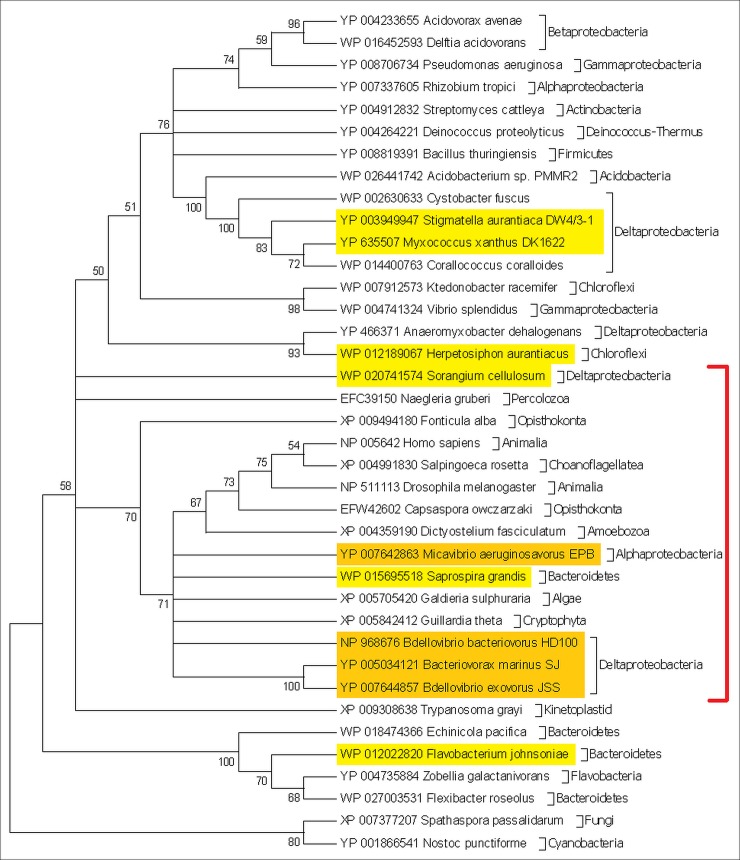
Maximum-likelihood phylogenetic tree of the tryptophan 2,3-dioxygenase protein.The percentage of trees in which the associated taxa clustered together (out of 100 bootstraps) is shown next to the branches; branches with <50% were collapsed. Obligate bacterial predators are marked orange, facultative yellow. Red line indicates genomes with the ~60 amino acid-long insert.